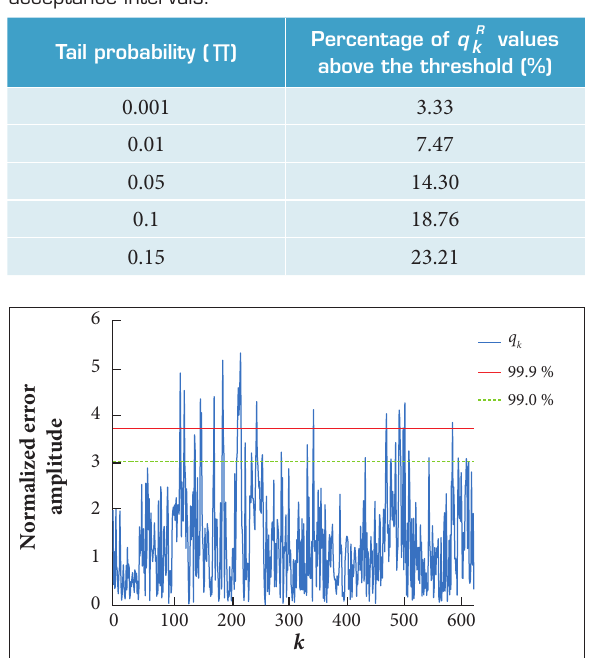
table 1. Quantitative evaluation of samples outside acceptance intervals.